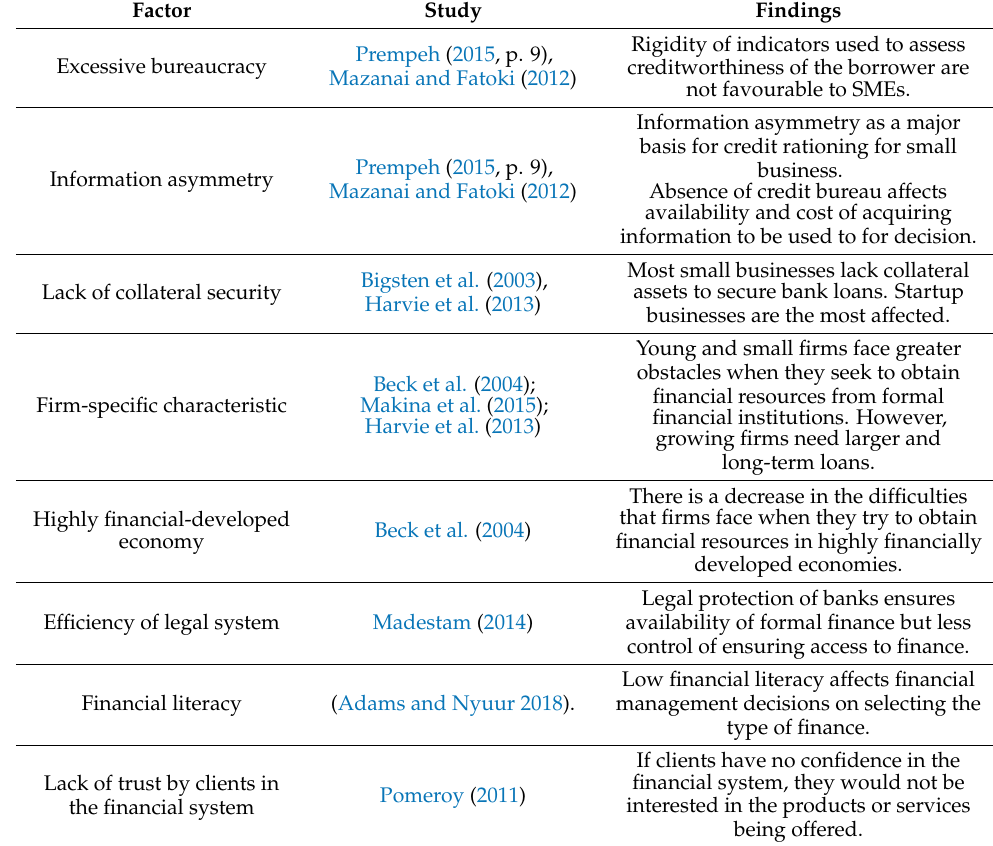
Table 2. A summary of factors affecting access to formal finance by the SMEs in